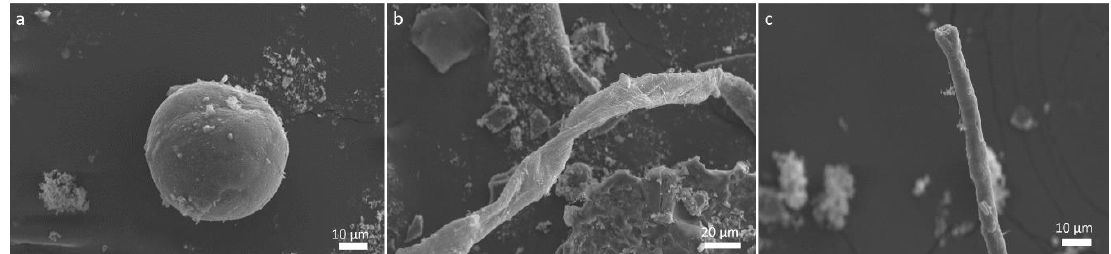
Figure 1. SEM images of the residues obtained after shock processing glycine. ( a ) globule structure, ( b ) fine filamentous thread feature and ( c ) cylindrical fibril feature.